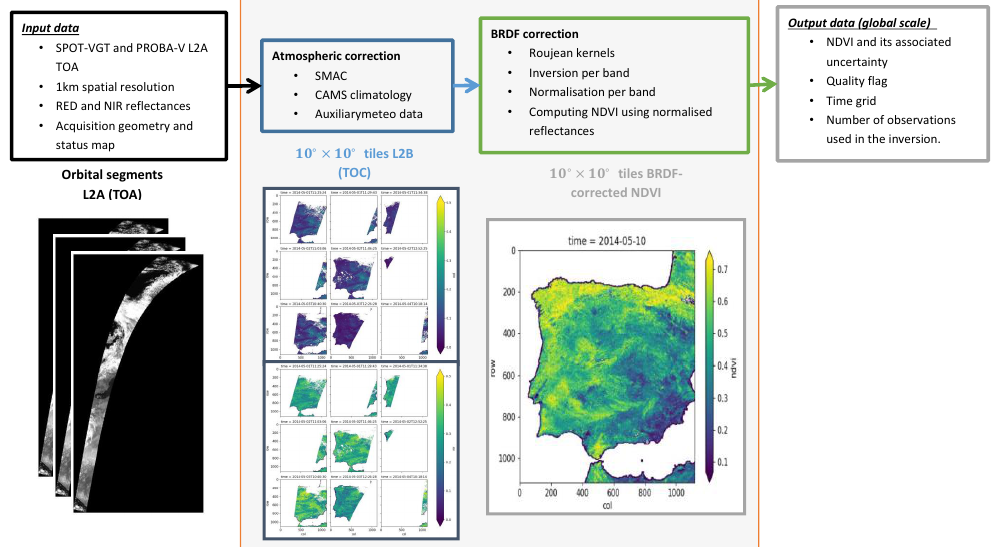
Figure 1. General overview of the processing of BRDF-adjusted NDVI Time-Series based on the VEGETATION instruments embarked on SPOT-4 (VGT1: March 1998–July 2003), SPOT-5 (VGT2: May 2002–May 2014) and PROBA-V (VGTPV: May 2013–June 2020)